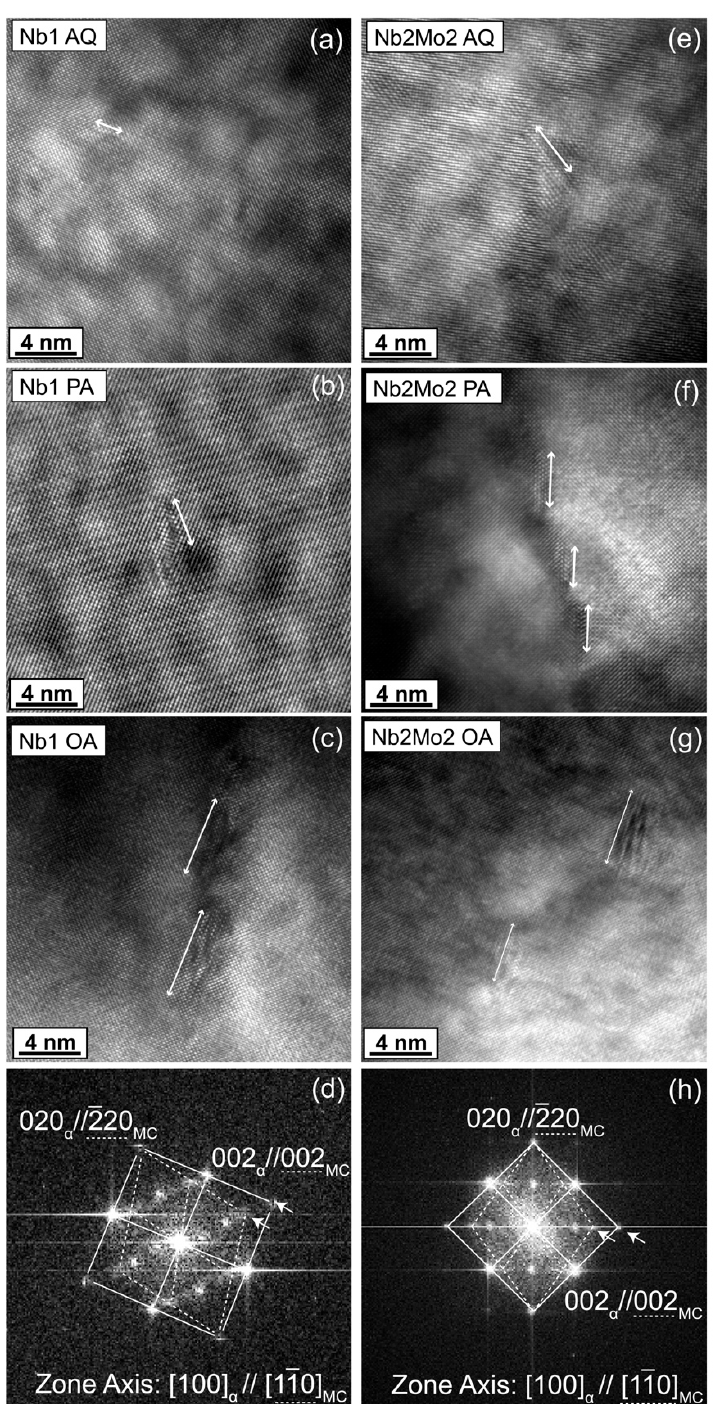
Figure 8. High-resolution transmission electron microscopy (HR-TEM) showing the precipitates in the Nb1 and Nb2Mo2 steels: ( a ) as-quenched Nb1; ( b ) peak-aged Nb1; ( c ) over-aged Nb1; ( d ) fast Fourier transform diffractogram for the carbide and ferrite of peak-aged Nb1; ( e ) as-quenched Nb2Mo2; ( f ) peak-aged Nb2Mo2; ( g ) over-aged Nb2Mo2; ( h ) fast Fourier transform diffractogram for the carbide and ferrite in peak-aged Nb2Mo2. The arrows in the FFT images indicated the corresponding index of diffraction spots which belong to matrix and carbides.